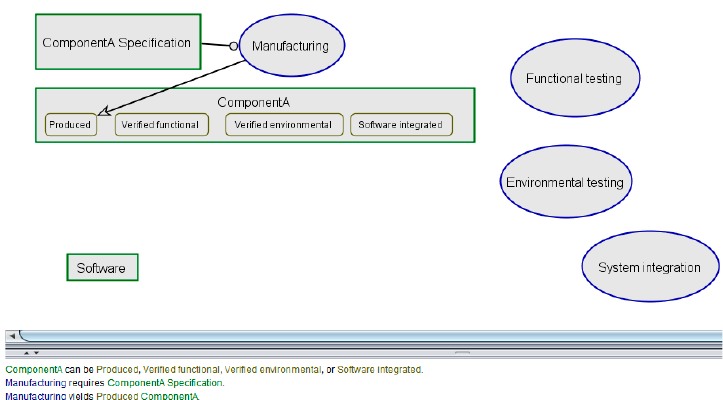
Figure 6. Linking objects and process, option #5.